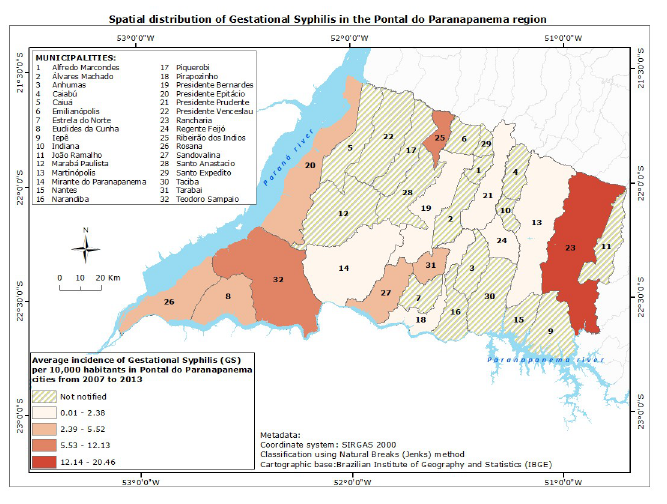
Fig 6. Pontal do Paranapanema cities and the spatial distribution of gestational syphilis reported cases from 2007 to 2013. The highest incidence of cases among the cities is represented by Rancharia (red), followed by Ribeir ã o dos I´ndios and Teodoro Sampaio (orange). The lowest index average incidences were identified in Martino´polis, Presidente Prudente, Presidente Bernardes e Mirante do Paranapanema (beige). Cities that reported cases of GS are located in the state border with Mato Grosso do Sul (West) and Parana (South). Databases: Brazilian Institute of Geography and Statistics—IBGE (2010) and National System of Aggravations and Notification–SINAN (2017).